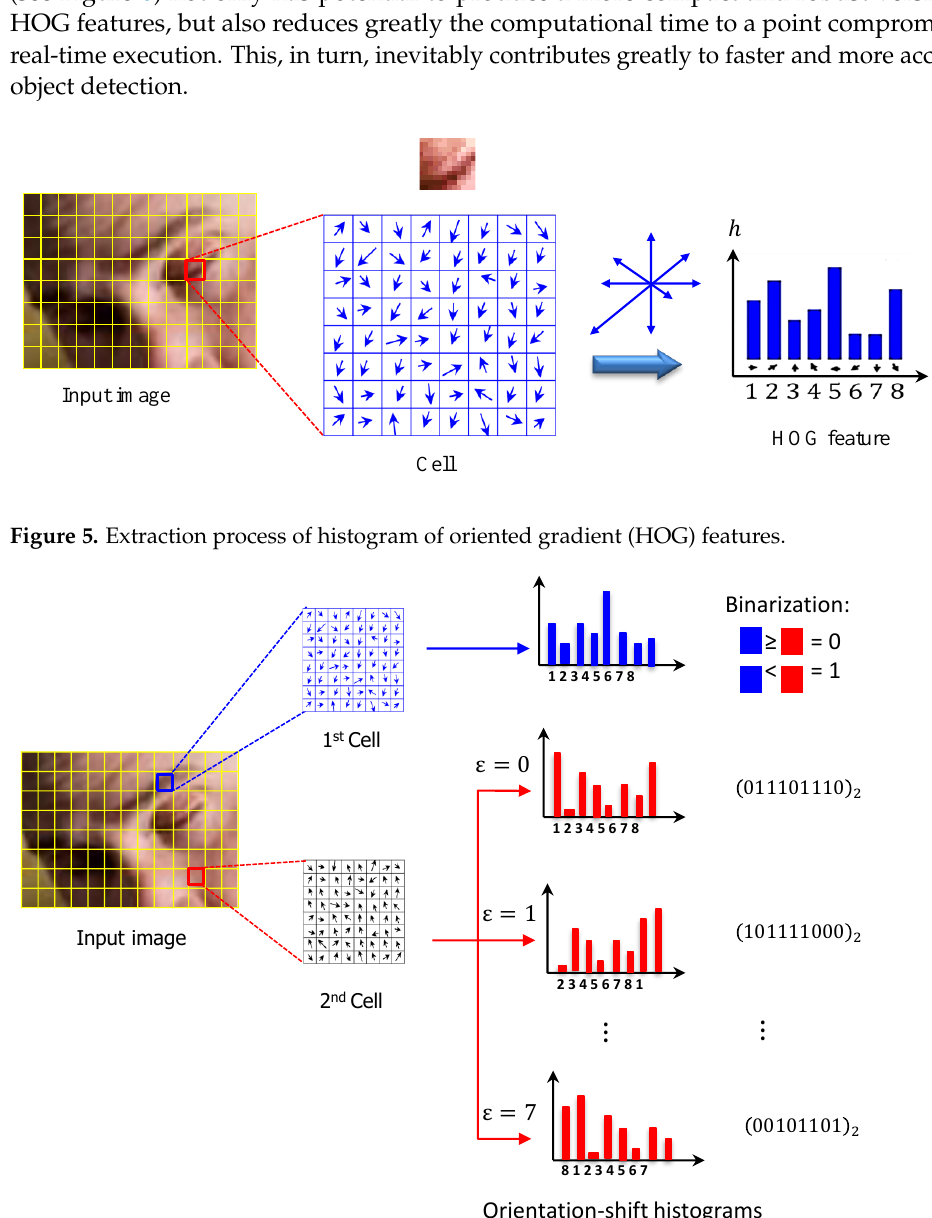
Figure 6. HOG feature extraction with a shift in the